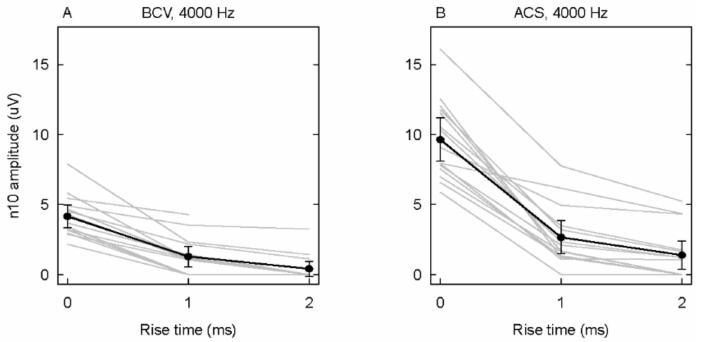
Figure 2. The averaged oVEMP n10 to 4000 Hz (( A ) for BCV and ( B ) for ACS) at each rise time for individual patients (gray lines) and the mean across patients in black lines with error bars as 95% confidence